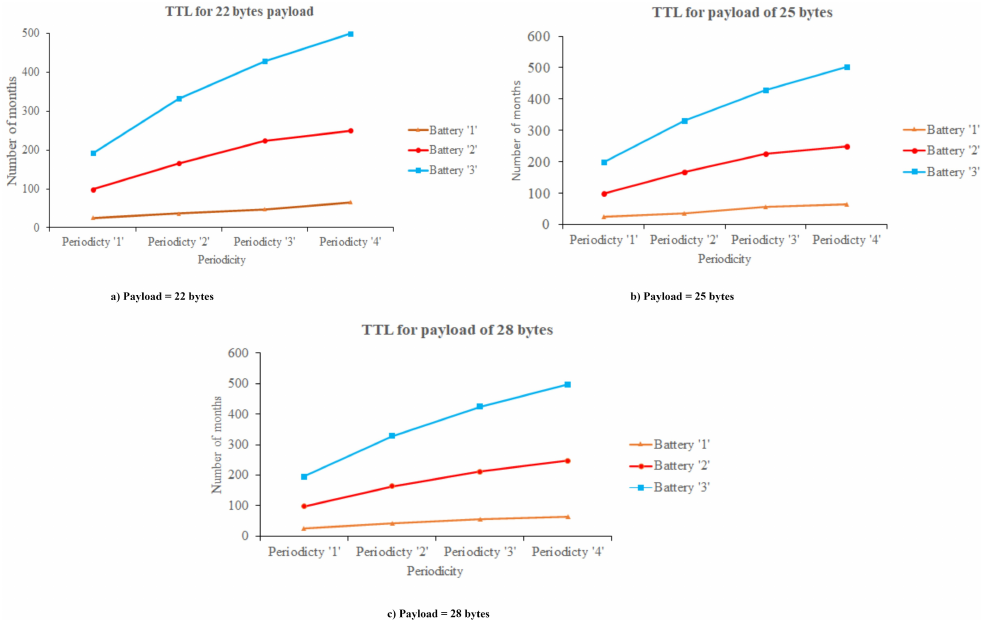
Figure 12. Time to live (TTL) of sensor